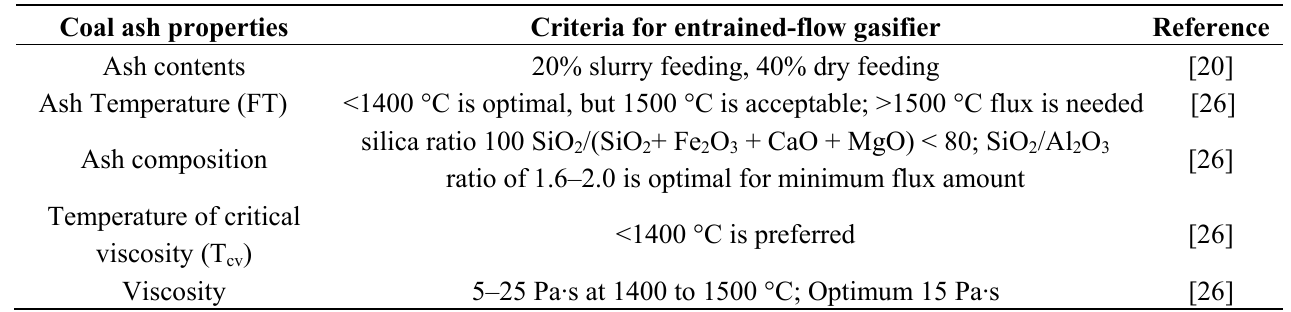
Table 3. Summary of criteria for coal ash properties for entrained-flow gasifiers [20,26,39]. Coal ash